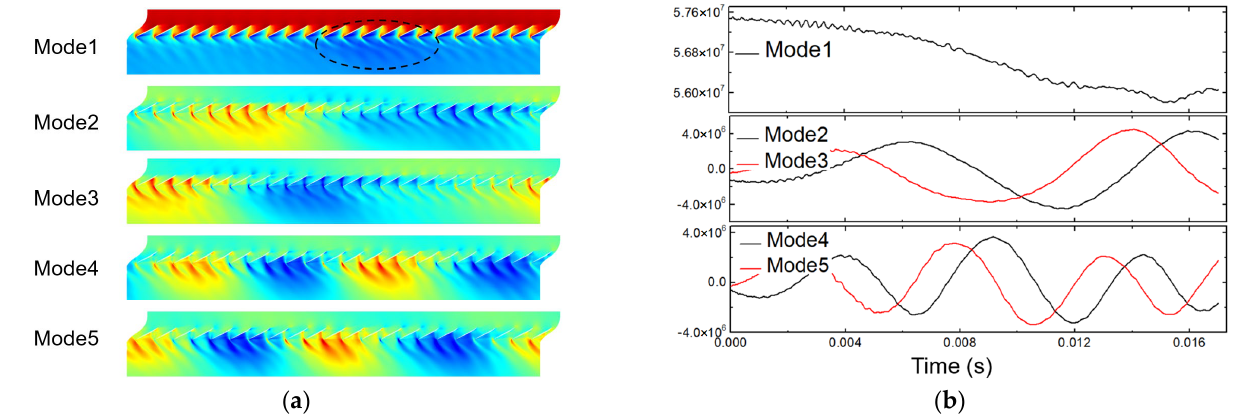
Figure 19. POD modes of the during-stall stage. ( a ) POD modes. ( b ) Mode coefficient.